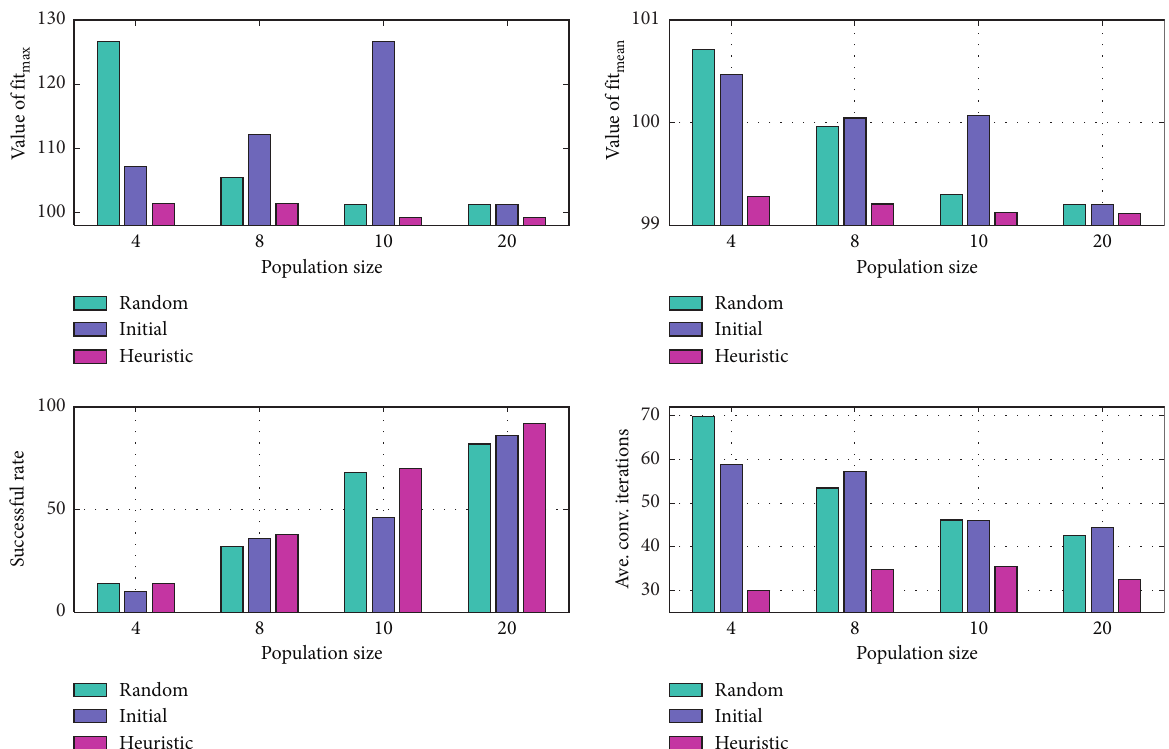
Figure 11: Comparisons among three initialization methods in terms of fit